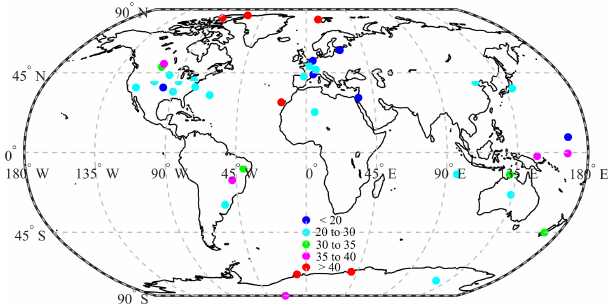
Figure 5. Spatial distribution of RMSE (Wm − 2 ) for our estimated daily SSR (spatial resolution 90km) at 42 BSRN stations.